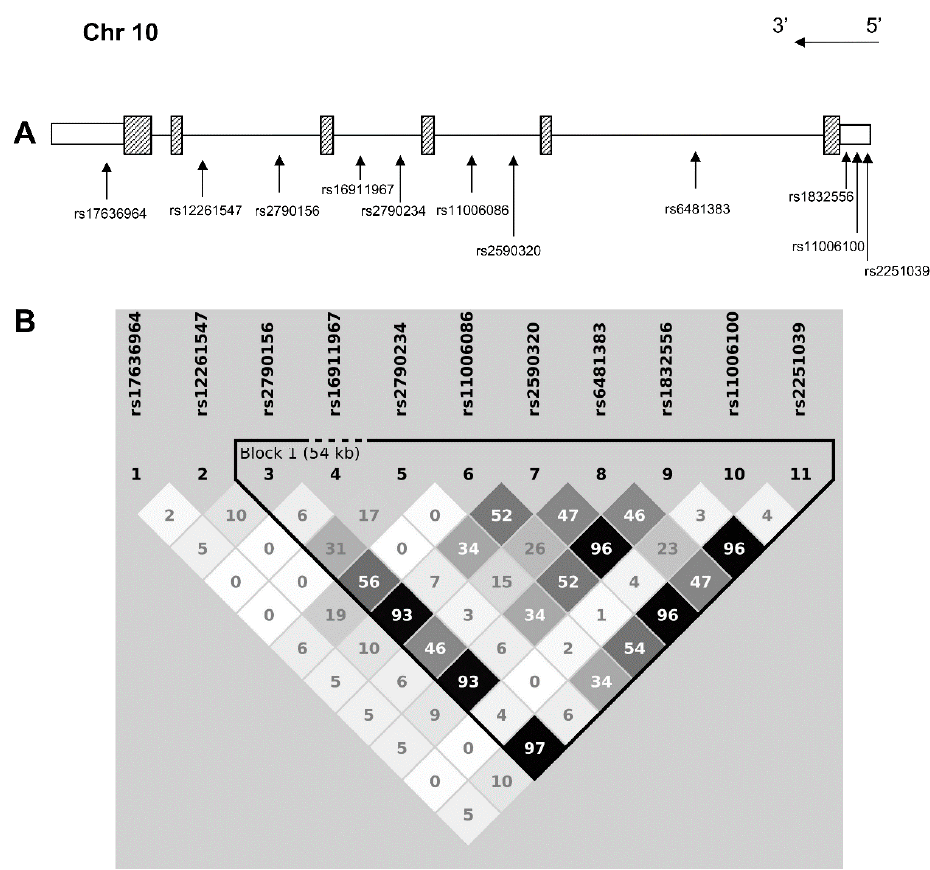
Figure 1. Schematic representation of ( A ) selected polymorphisms in the Inositol Polyphosphate Multikinase ( IPMK ) region; ( B ) linkage disequilibrium (r 2 coefficient) among the single nuclear polymorphisms